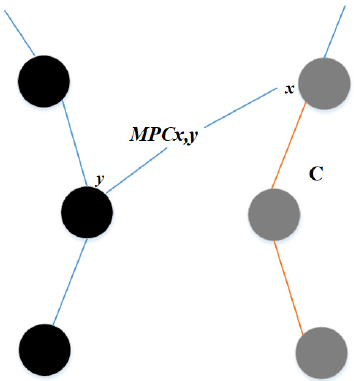
Figure 6. Scenario 1, where x is a border node of cluster C.